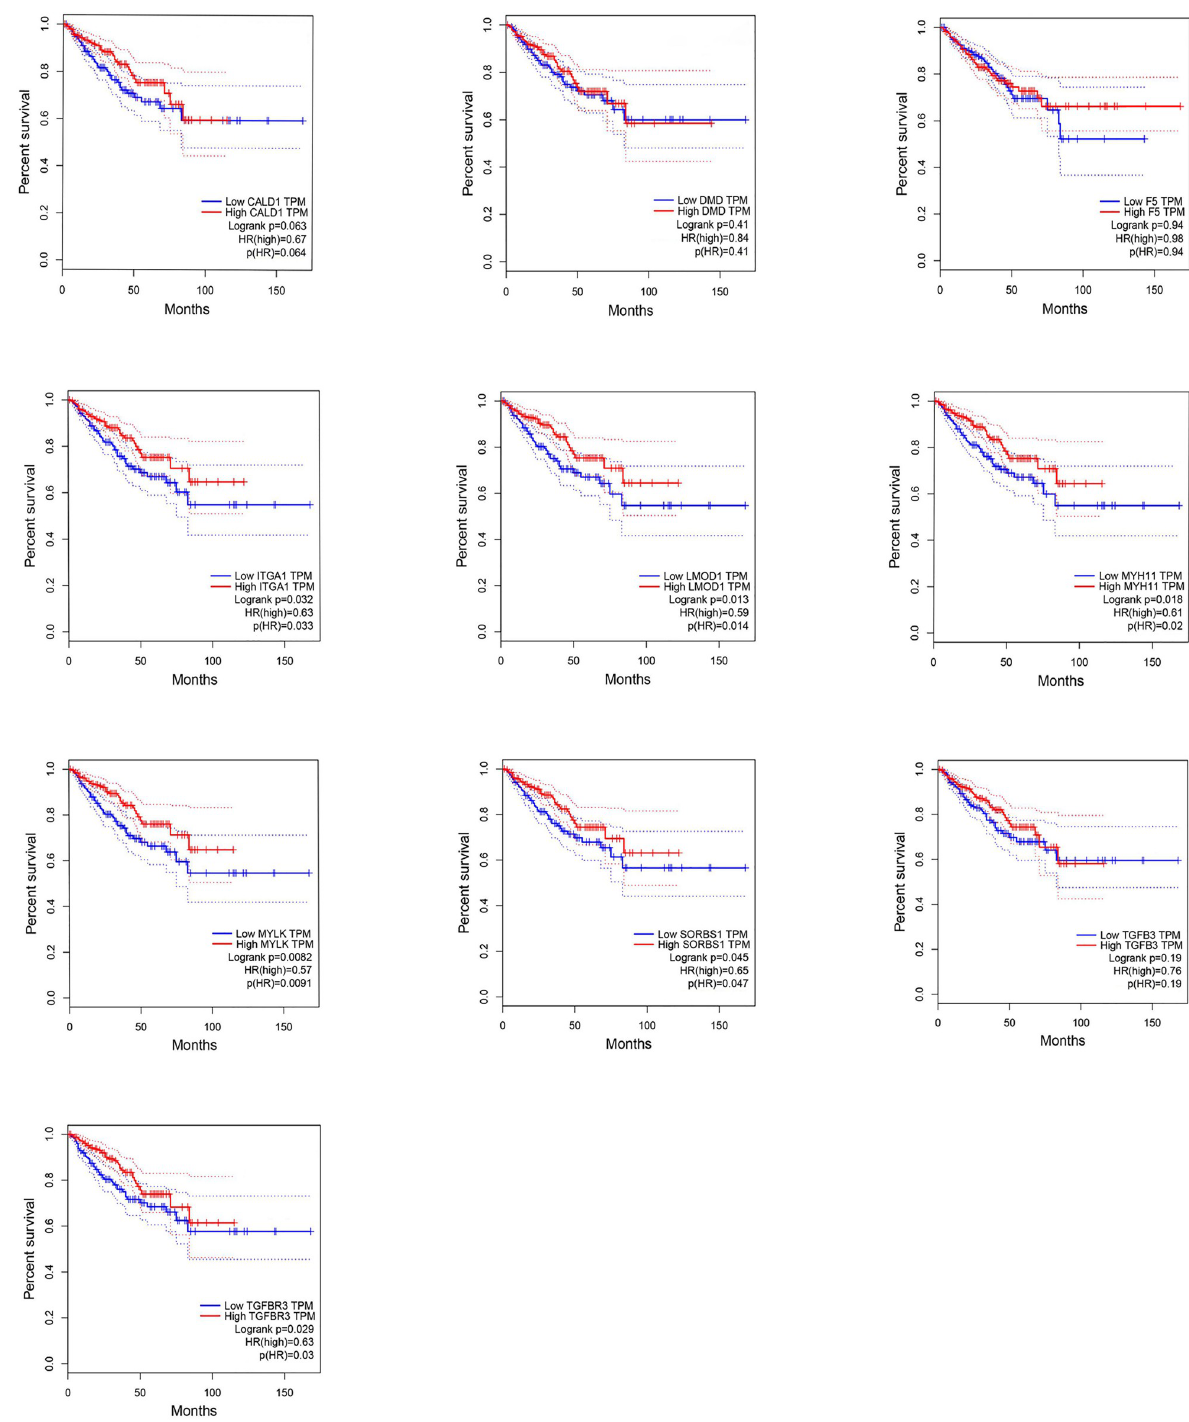
Fig 7. Disease-free survival plot of 10 hub genes.